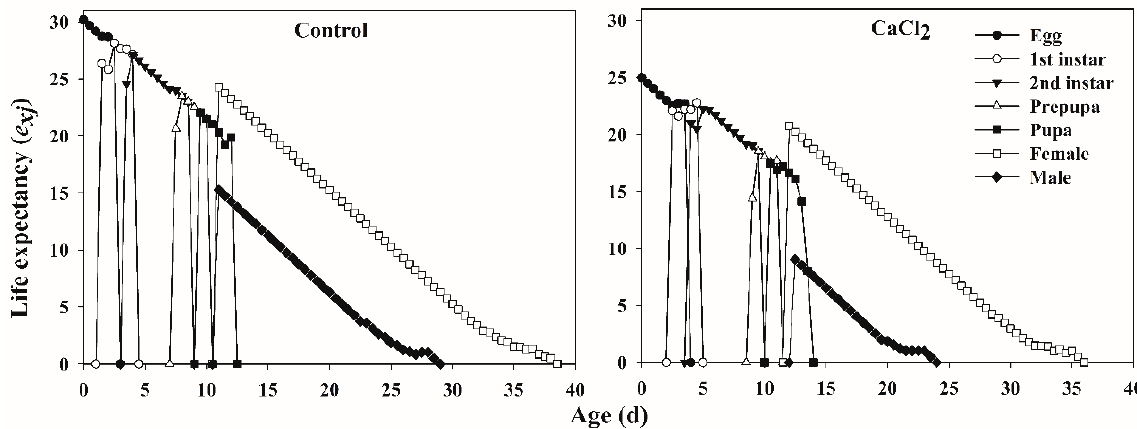
Figure 3. The age-stage-specific life expectancy ( e xj ) of Frankliniella occidentalis fed on control and Ca-treated kidney bean leaves.